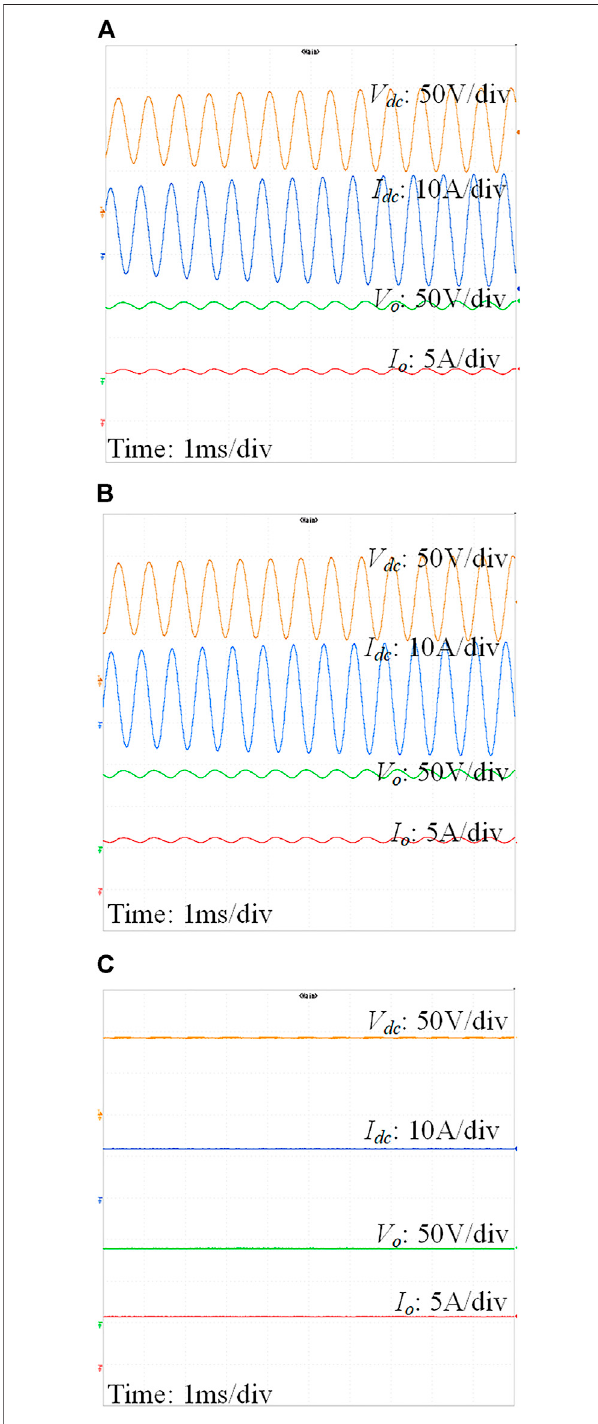
FIGURE14| WaveformsofDABconvertersinclosed-loopoperation (A) SPS; (B) DPS; (C) CTPS.